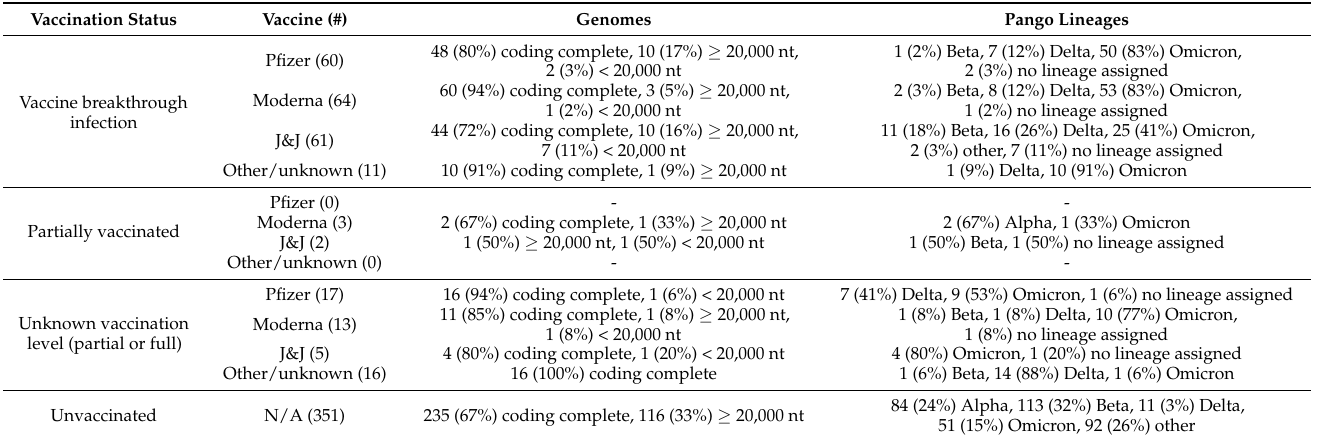
Table 1. Summary of vaccine breakthrough, partial breakthrough, unknown vaccination status, and unvaccinated cases in